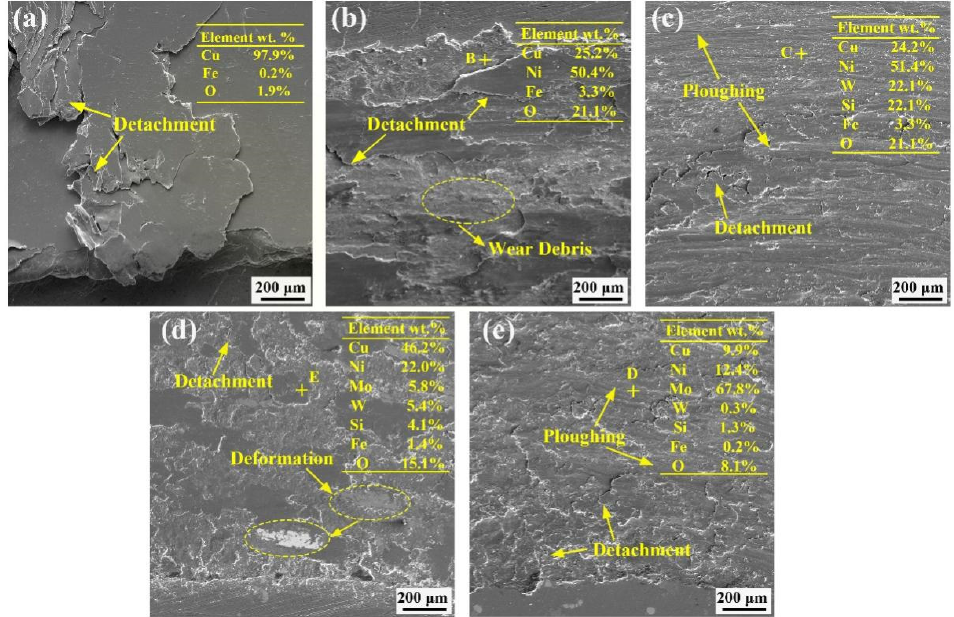
Figure 12. The micromorphology wear scars: ( a ) Cu–Cr–Zr substrate; ( b ) Ni–Cu coating; ( c ) Ni–Cu– 10(W,Si) coating; ( d ) Ni–Cu–10(Mo,W,Si) coating; ( e ) Ni–Cu–15(Mo,W,Si) coating.